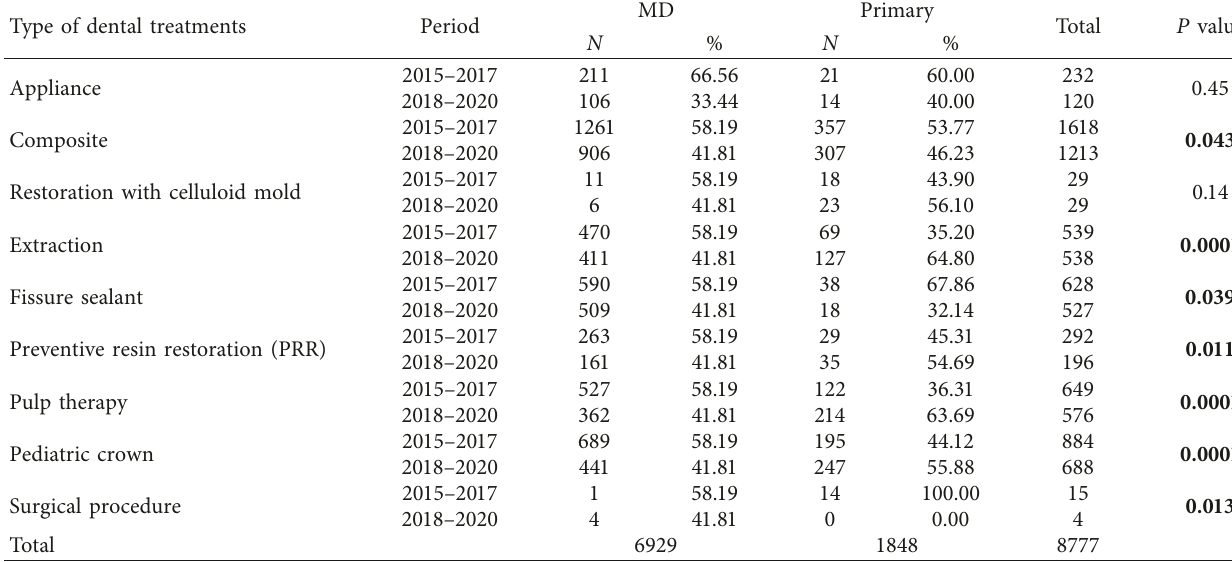
Table 4: Comparison between all types of dental treatments performed in 2015–2017 and those performed between 2018 and 2020 in both